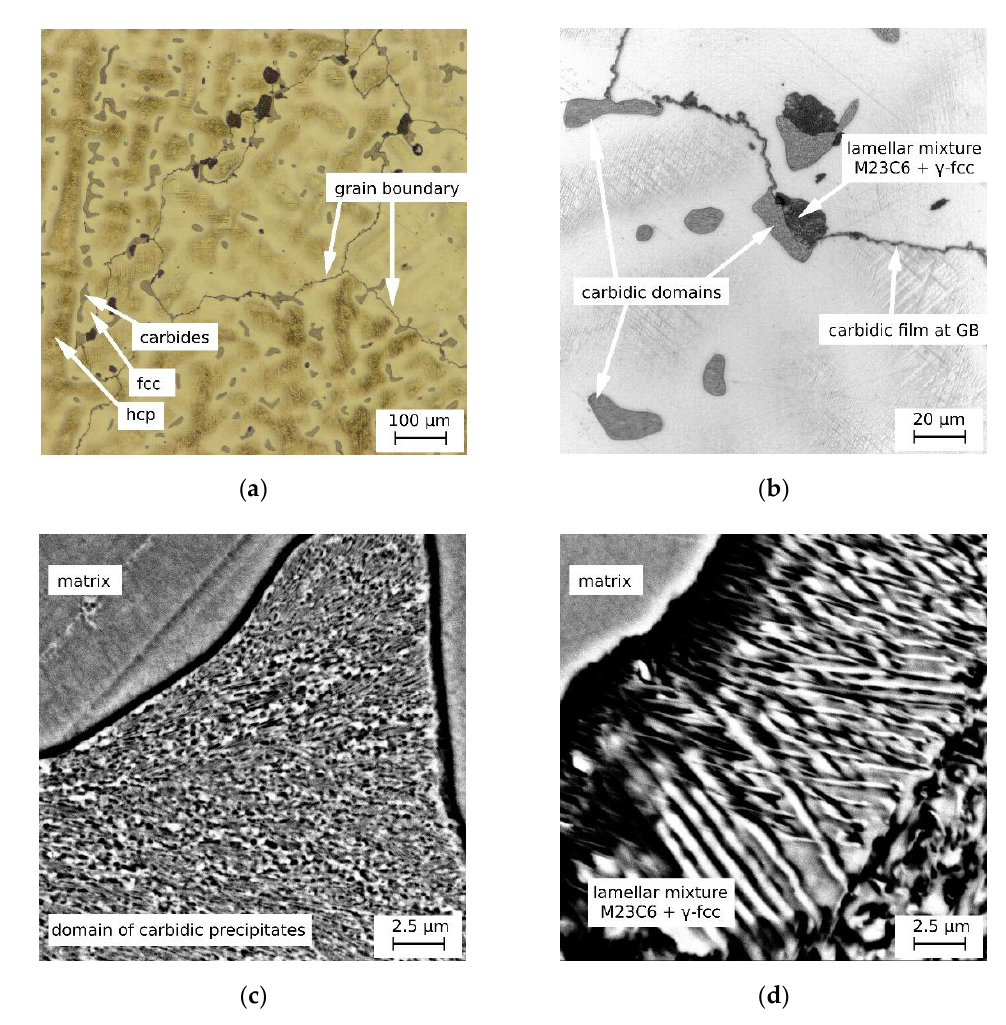
Figure 4. Initial microstructure of the cast Co-Cr-Mo alloy: ( a , b ) OM; ( c , d ) SEM. The XRD analysis determined the presence of two types of carbides: M 23 C 6 (5.0%) and M 6 C (1.3%). However, as visible from the micrographs (Figure 4b – d), carbides occur in